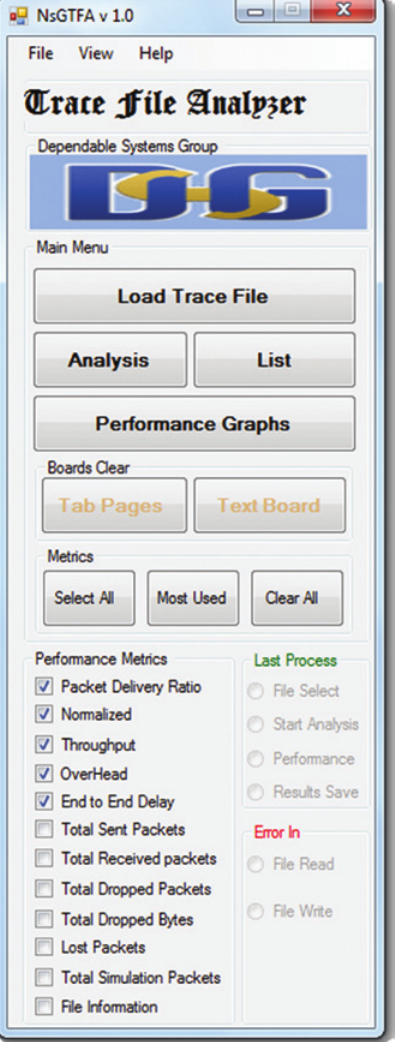
Figure 3. NsGTFA Main Window.